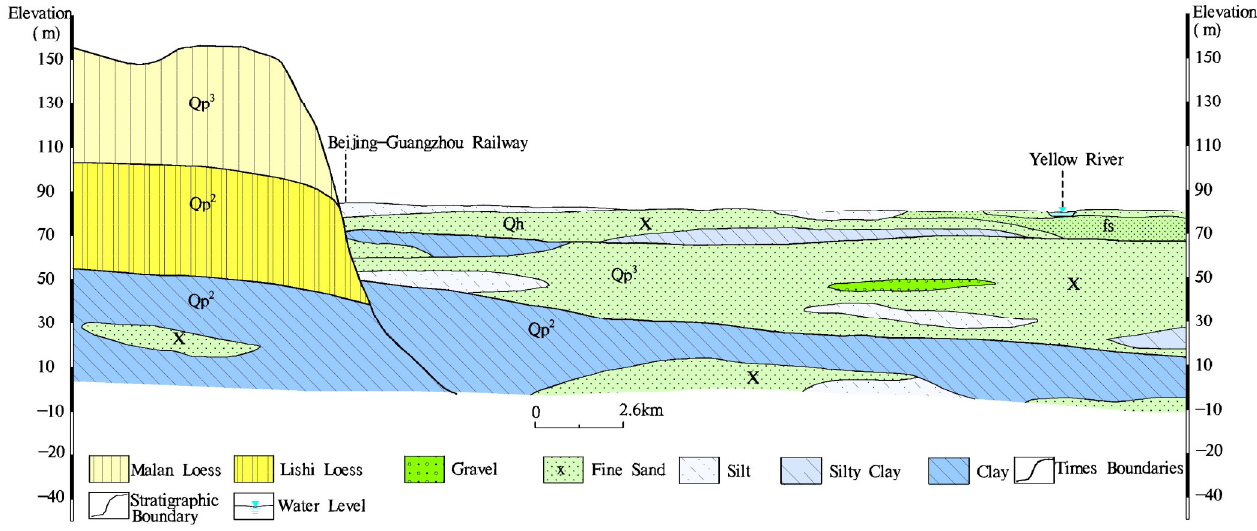
Figure 2. Hydrogeological profile of the study area.